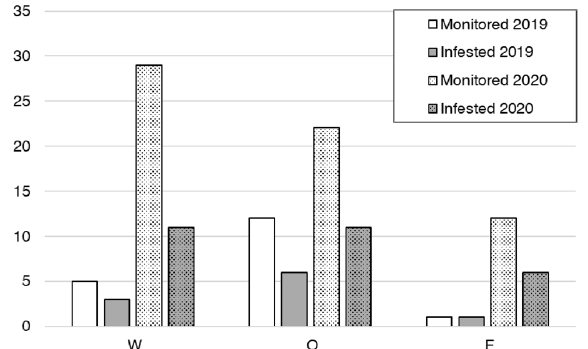
Figure 3. Subdivision of monitored and infested sites monitored in 2019–2020. Warehouses: W; walnut orchards: O; farms: F.